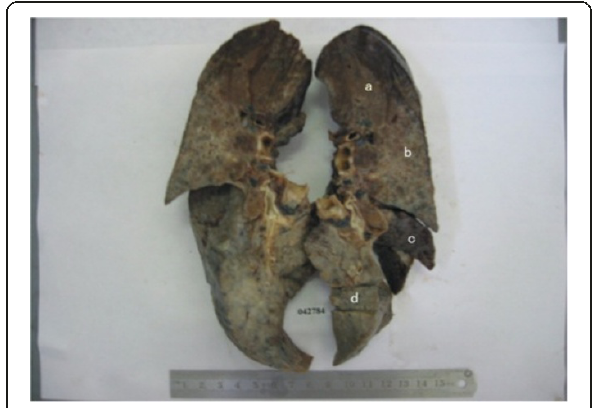
Figure 2 The pathological gross examination of whole lung specimen. Examining removed right lung, the apicoposterior segment of upper lobe was dark red, anterior segment was grey red alternated with grey white, middle and lower lobes was predominantly grey white. Getting specimenes from apicoposterior segment of upper lobe (a), anterior segment (b), middle (c) and lower lobe (d)